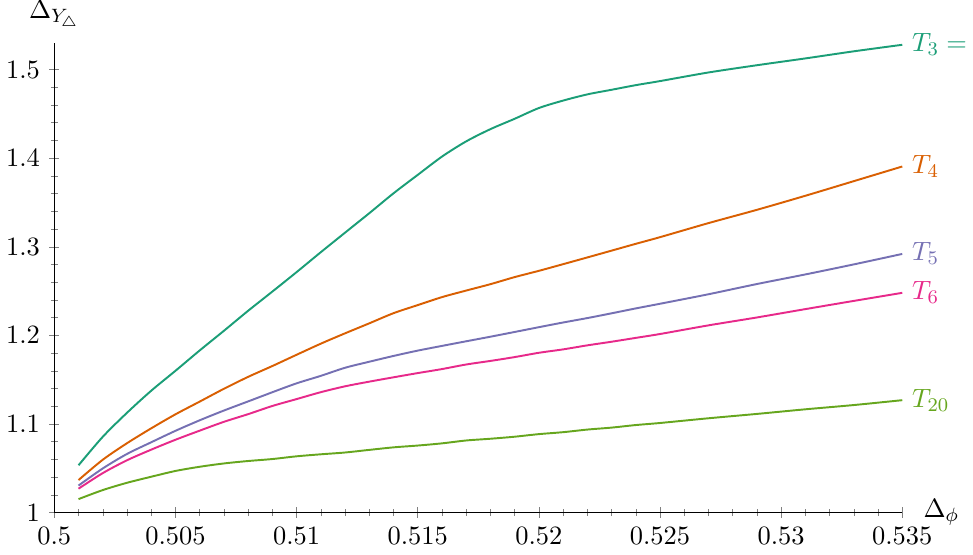
Figure 13 . Upper bound on the dimension of the (cid:12)rst scalar operator in the Y + (cid:30) (cid:11) (cid:2) (cid:30) (cid:12) OPE as a function of the dimension of (cid:30) . Areas above the curves are excluded in the corresponding